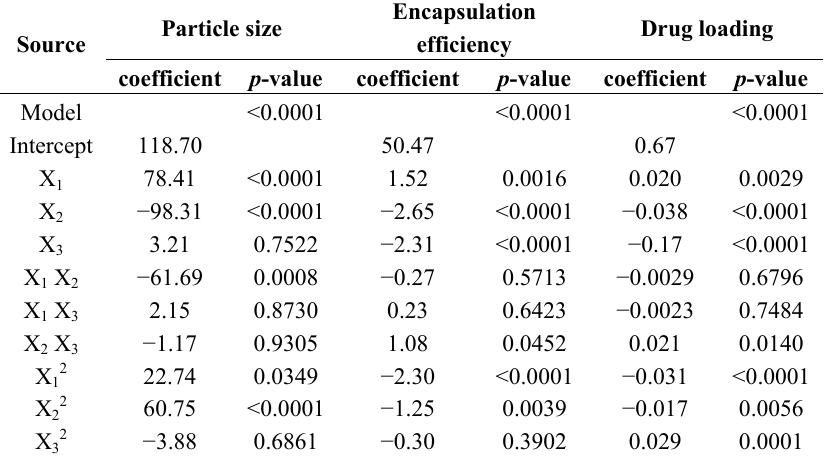
Table 2. Regression coefficients and analysis of variance (ANOVA) of the model : fraction of lipid (%, w/w), X parameters. X 1 : lipid to drug ratio X 3